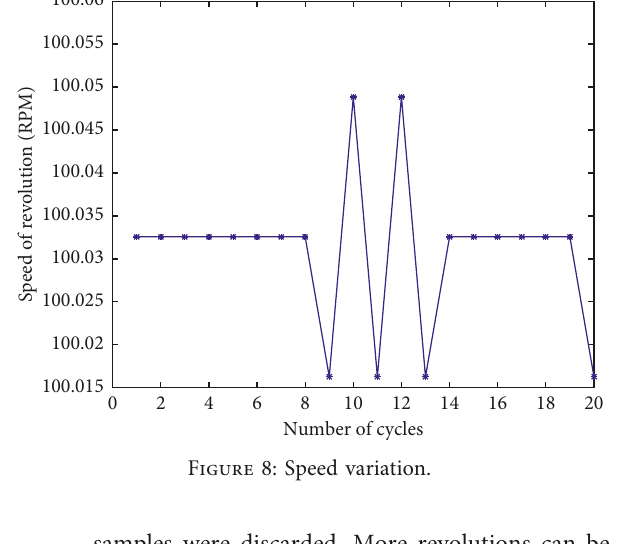
Figure 9: A raw BTT signal from the AECS at a speed of